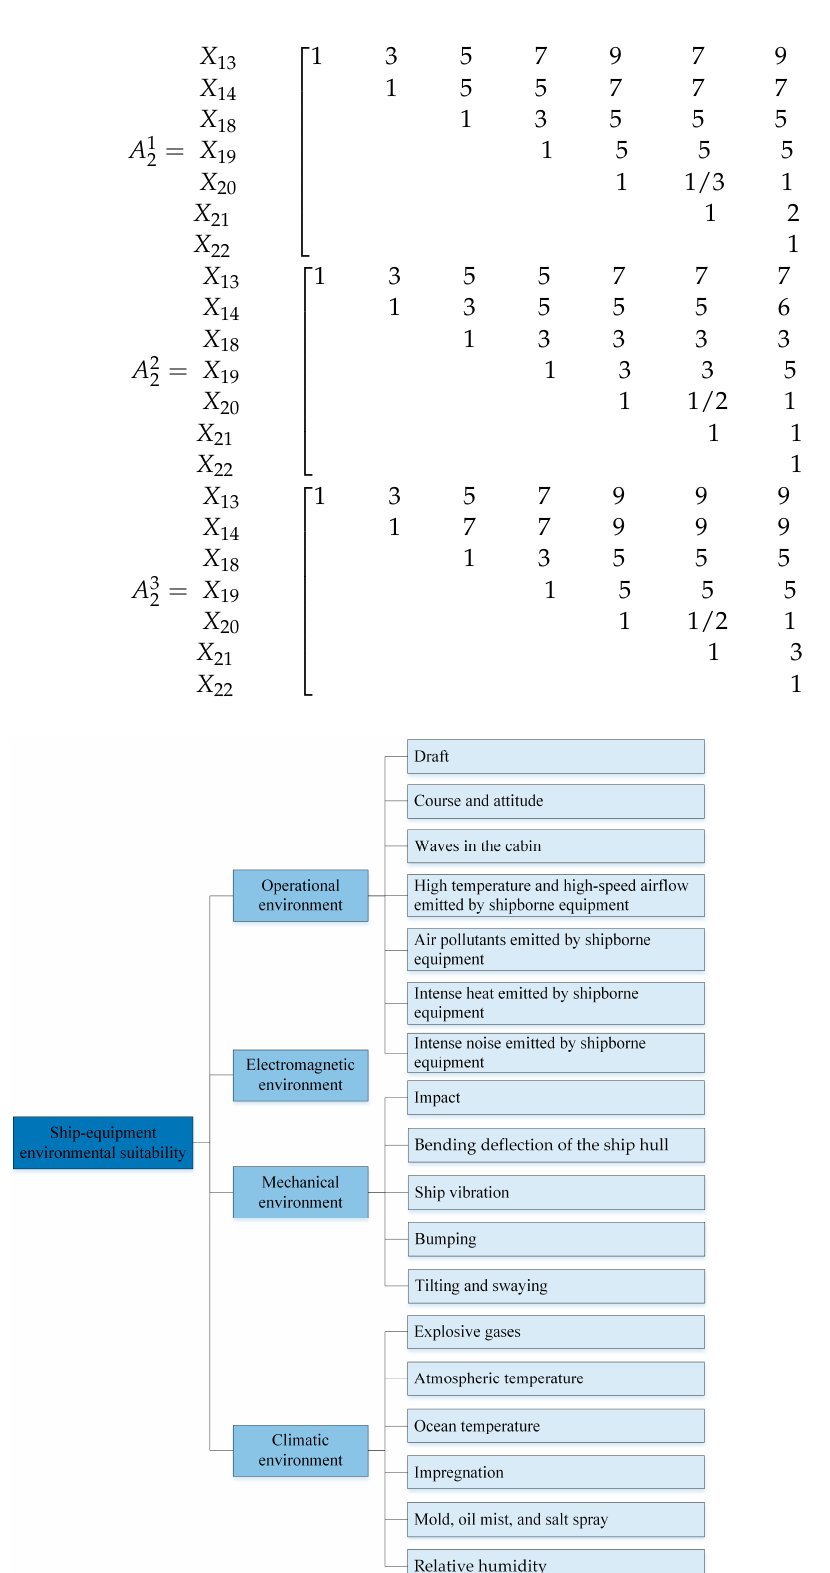
Figure 8. Evaluation index system of ship-equipment environmental suitability.